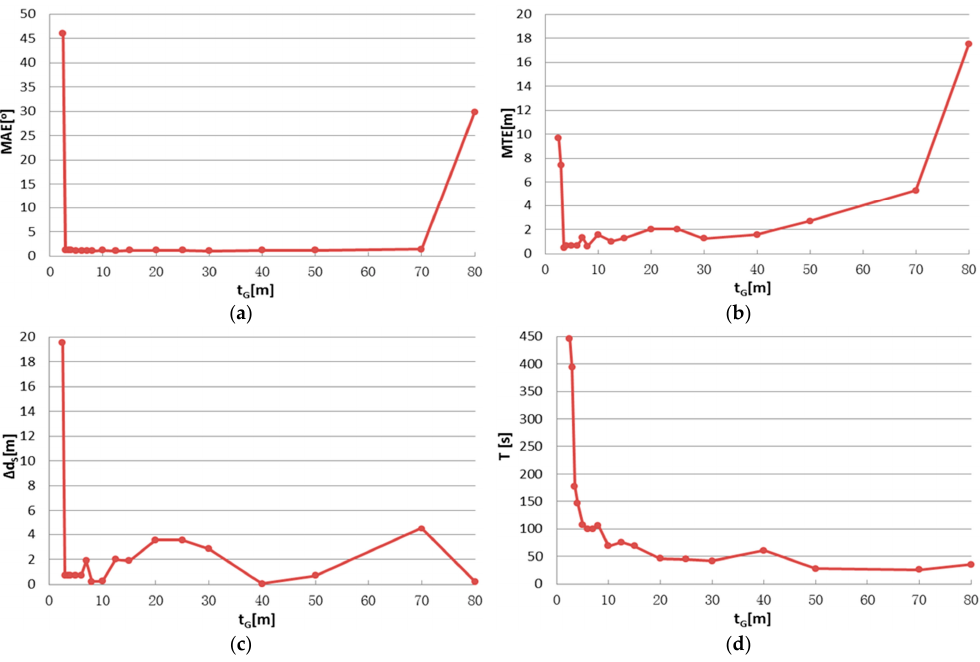
Figure 10. IME results with different t G , when d G is fixed to 2.5 m: ( a ) mean angular error (MAE); ( b ) mean translation error (MTE); ( c ) scan distance error ( ∆ d S ); and ( d ) runtime (T).